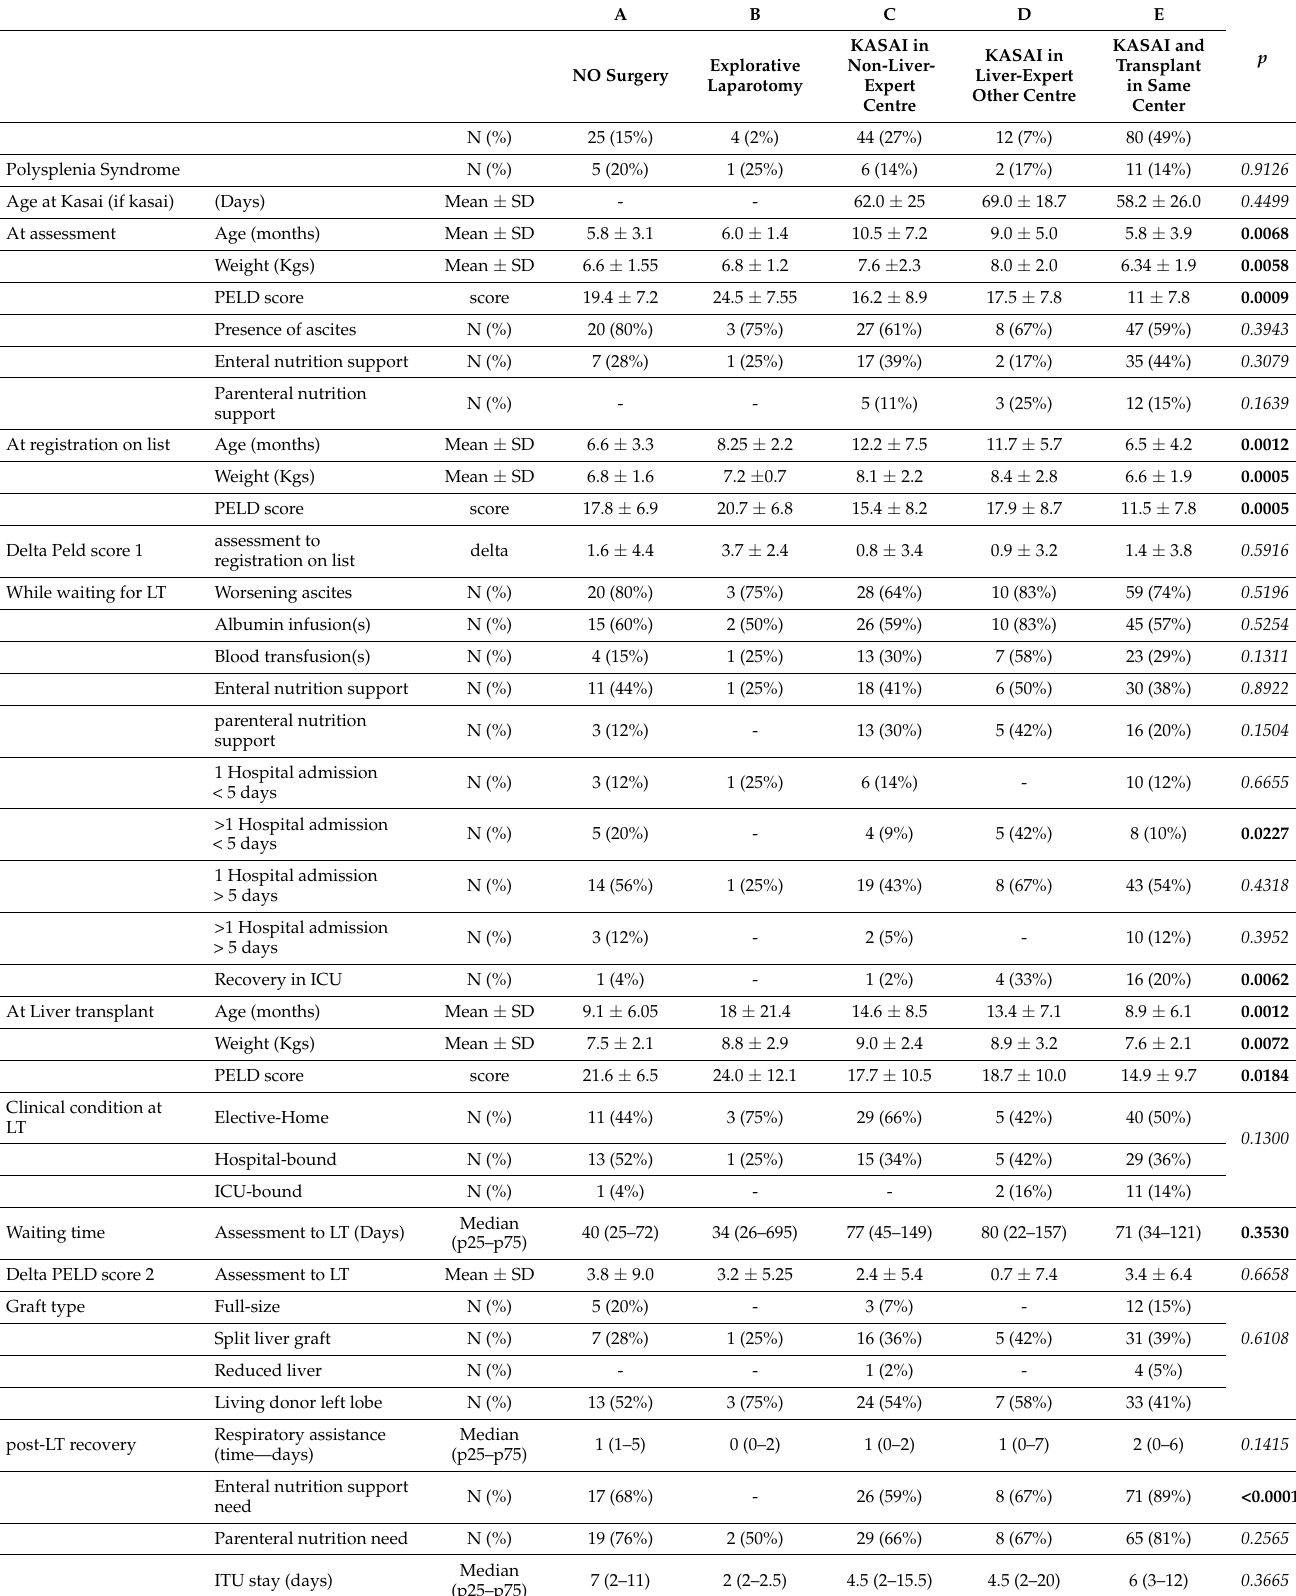
Table 1. Europe group: analysis of subgroups as per initial surgery for biliary